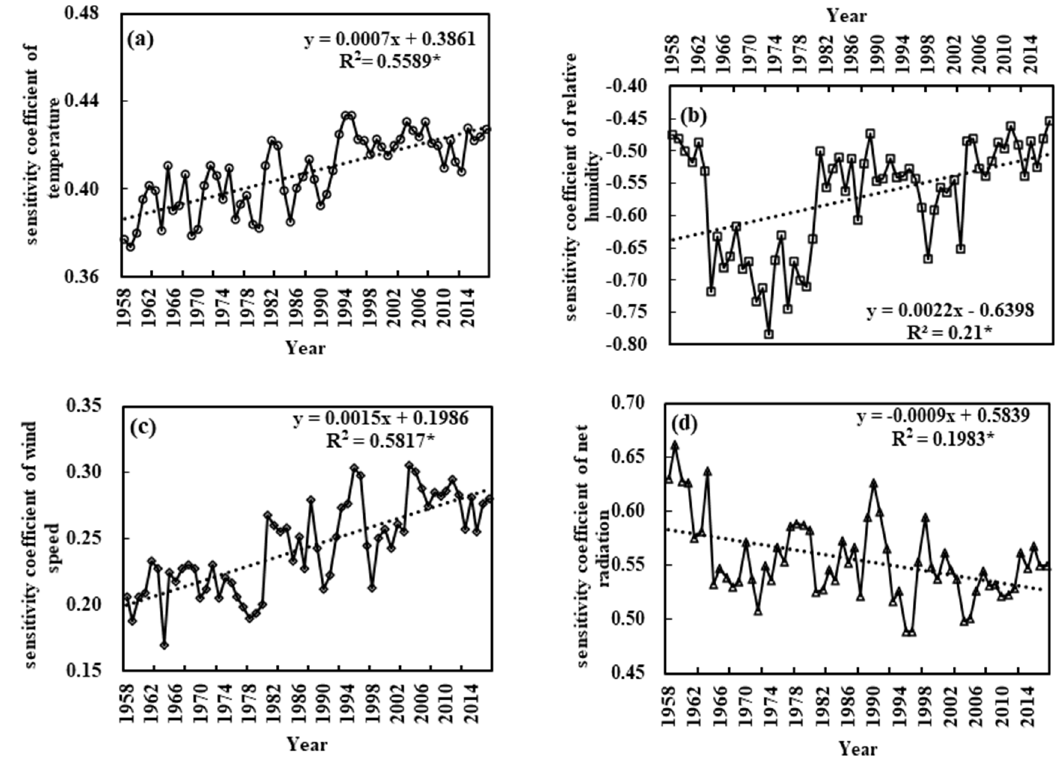
Figure 5. Interannual variations in the sensitivity coefficients of the four meteorological factors. (* indicates significance level of 0.05). ( Figures (a), (b), (c) and (d) represent the interannual variations in the sensitivity coefficients of T, RH, U and RN, respectively)